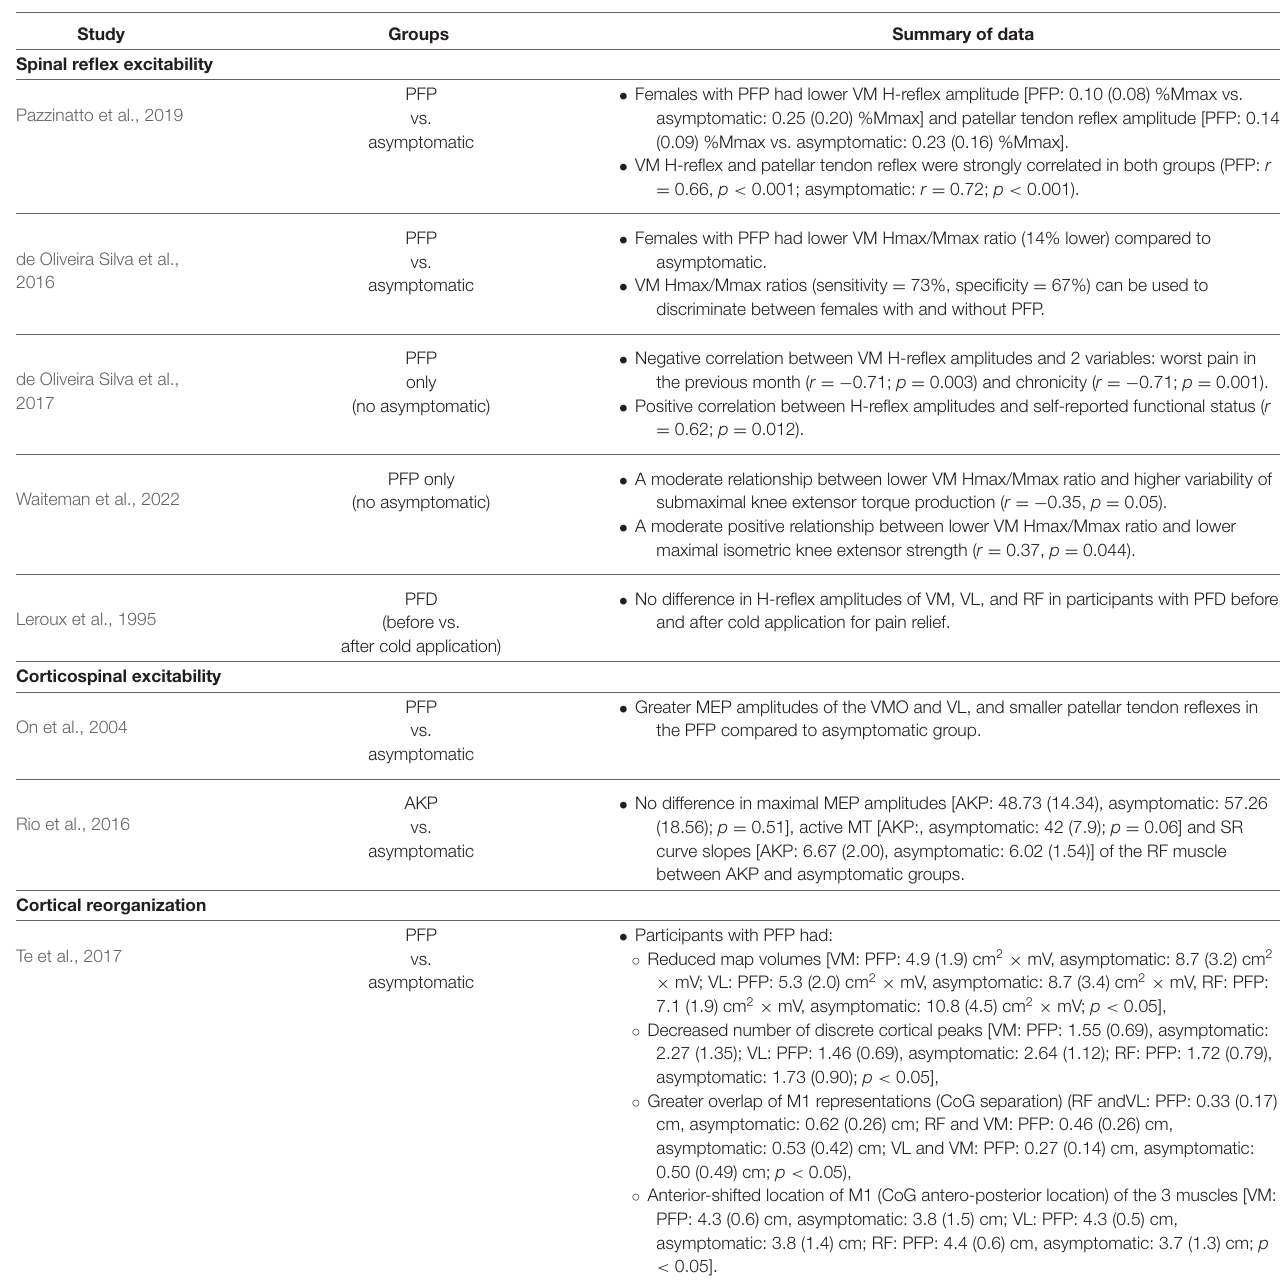
TABLE 3 | Primary outcomes for all included studies.